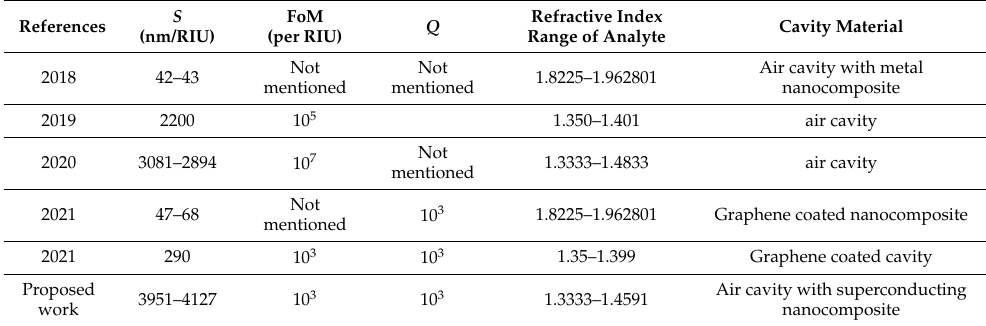
Table 5. Comparison between performance of present work with other design on the basis of numeric values of S , Q , and FoM